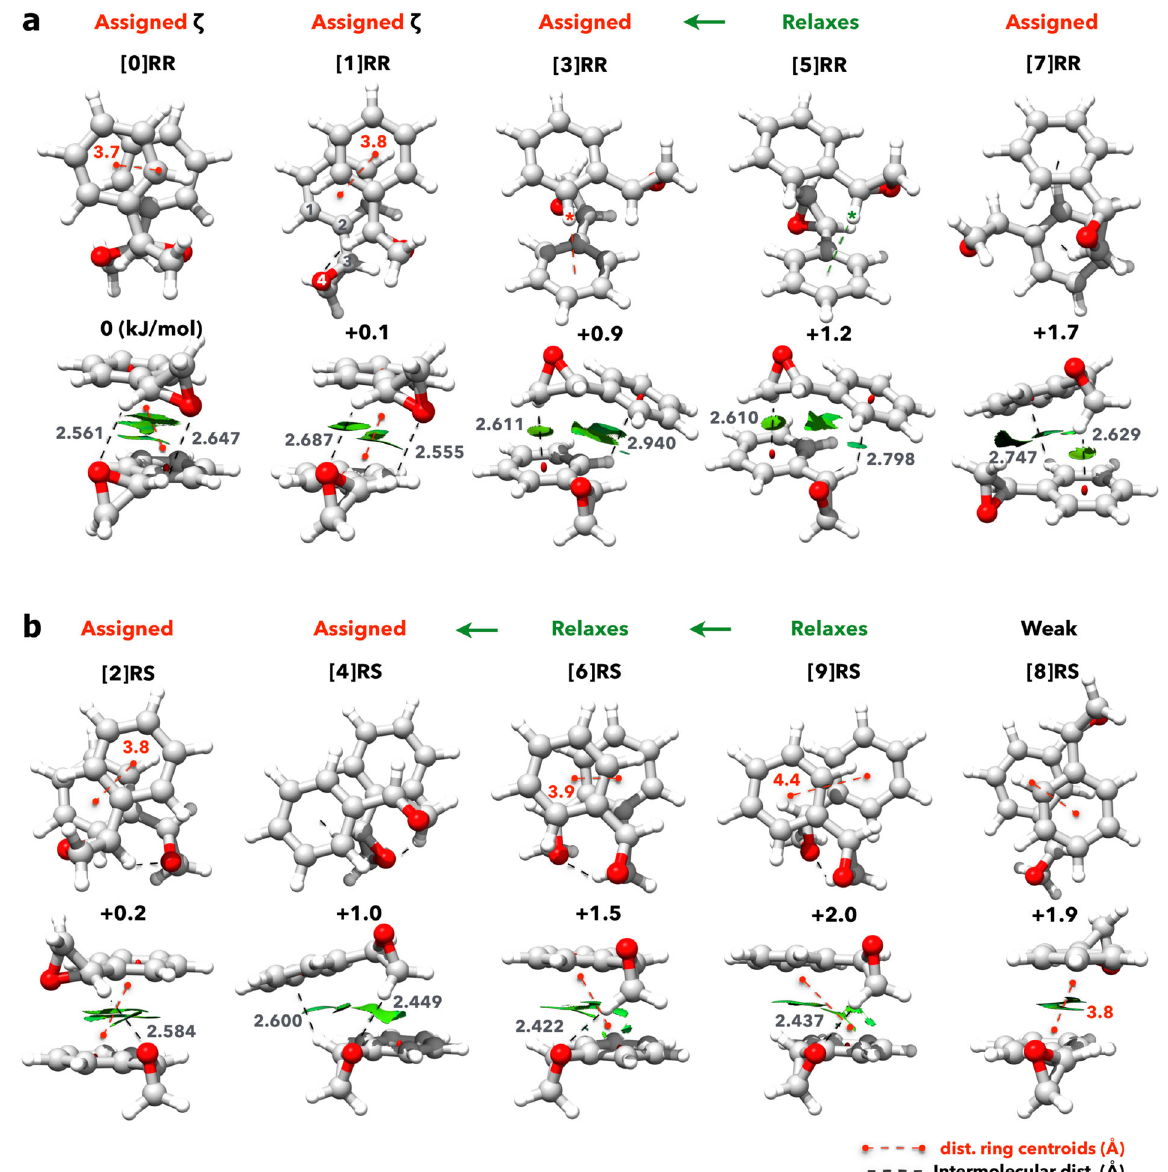
Fig. 1 Two views of the molecular geometries of the styrene oxide dimer calculated at the B3LYP-D3(BJ)/def2-TZVP level of theory. For each homochiral ( a ) and heterochiral dimer ( b ), relevant intermolecular interactions (distances given in Å ) are depicted and the NCI surfaces plotted. The values shown between the two views are the relative zero-point corrected energies (in kJ mol − 1 ) as reported in Table 1. The assigned dimers are highlighted in red, while the ones marked in green are shown to relax to lower energy forms (see section “ Relative stability and conformational fl exibility ” ). The ζ in dimers [0]RR and [1]RR represents an indirect assignment (see text for further explanation). The asterisk depicted for dimers [3]RR and [5]RR highlights the hydrogen atom that is interacting with the aromatic